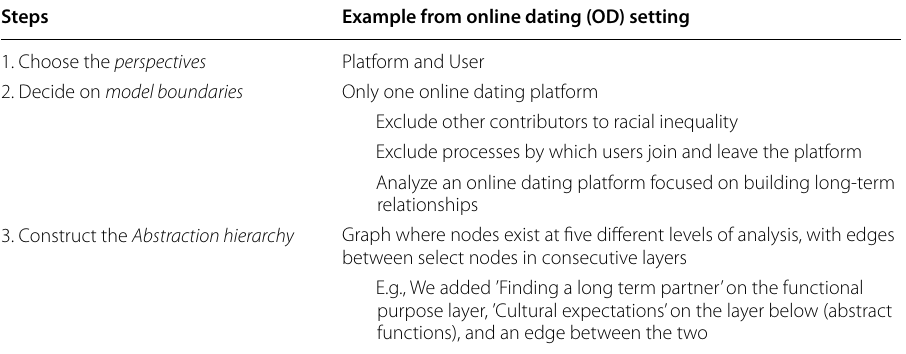
Table 1 An overview of the steps required for AH‑development with examples from our application to online